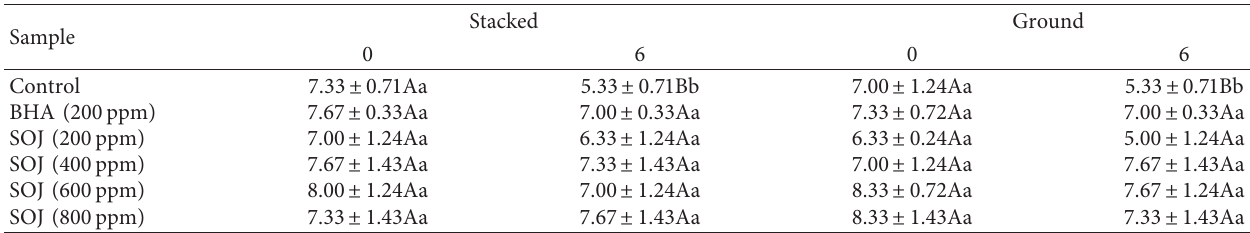
Table 8: Overall sensorial properties of stacked and ground meat samples incorporated with Shahpouri Orange Juice (SOJ) and BHA during storage at 4 ° C for 6